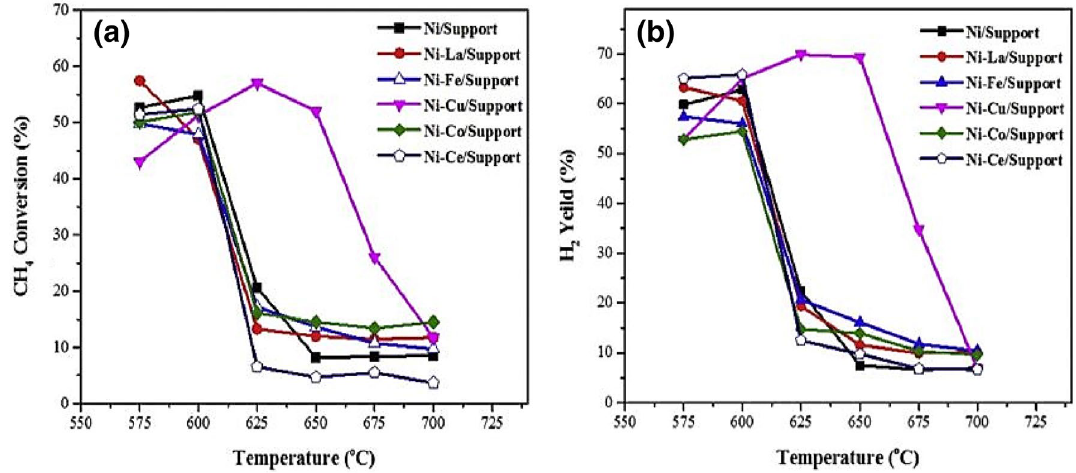
Fig. 7 Catalytic activity of promoted and unpromoted Ni/MgO·Al